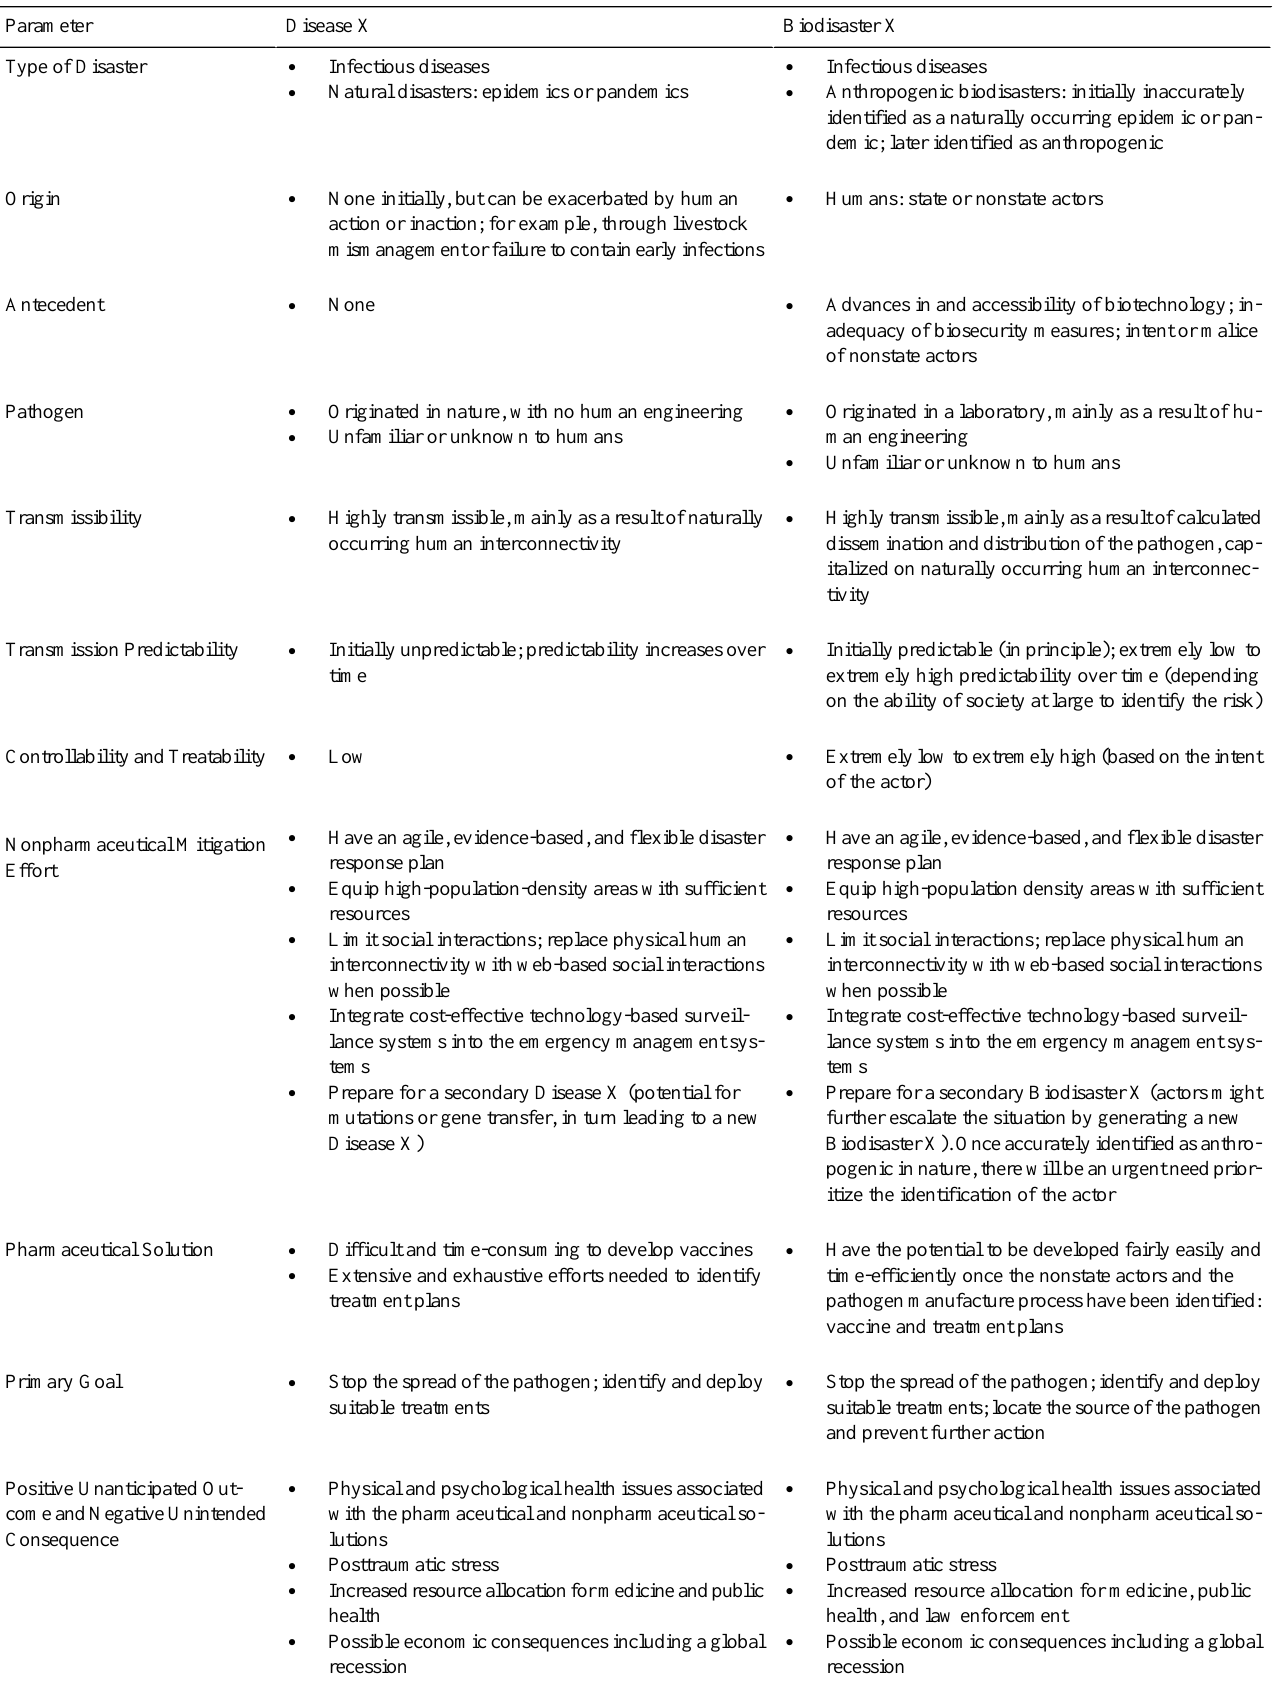
Table 3. Similarities and differences between Disease X and Biodisaster